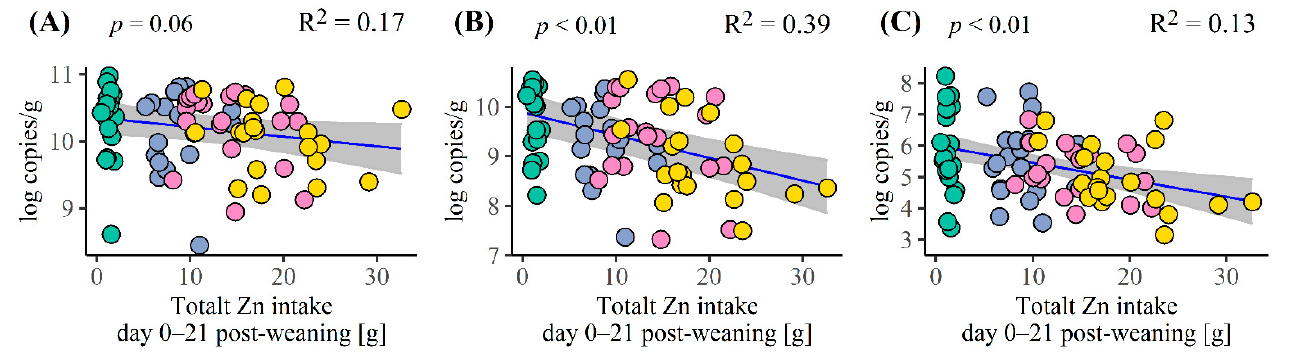
Figure 4. The correlation between the total zinc intake during the 21 days of the experiment and the faecal number of ( A ) total bacteria, ( B ) total Lactobacilli and ( C ) total Escherichia coli at day 21 post-weaning. The correlation is assessed based on the R 2 . The blue line illustrates the correlation and the grey area illustrate the 95% confidence interval (20 pigs/diet).